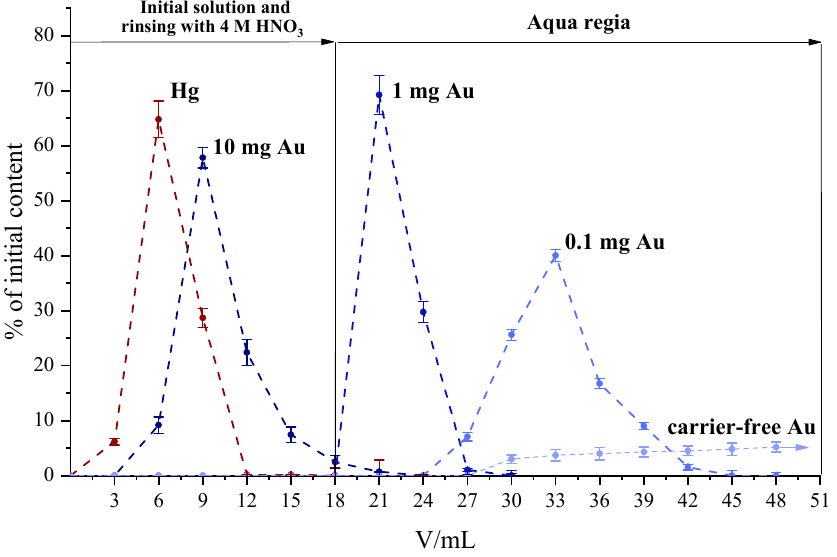
Figure 2. Elution curves of Hg and Au on a B15C5-30 column with the addition of various amounts of carrier.